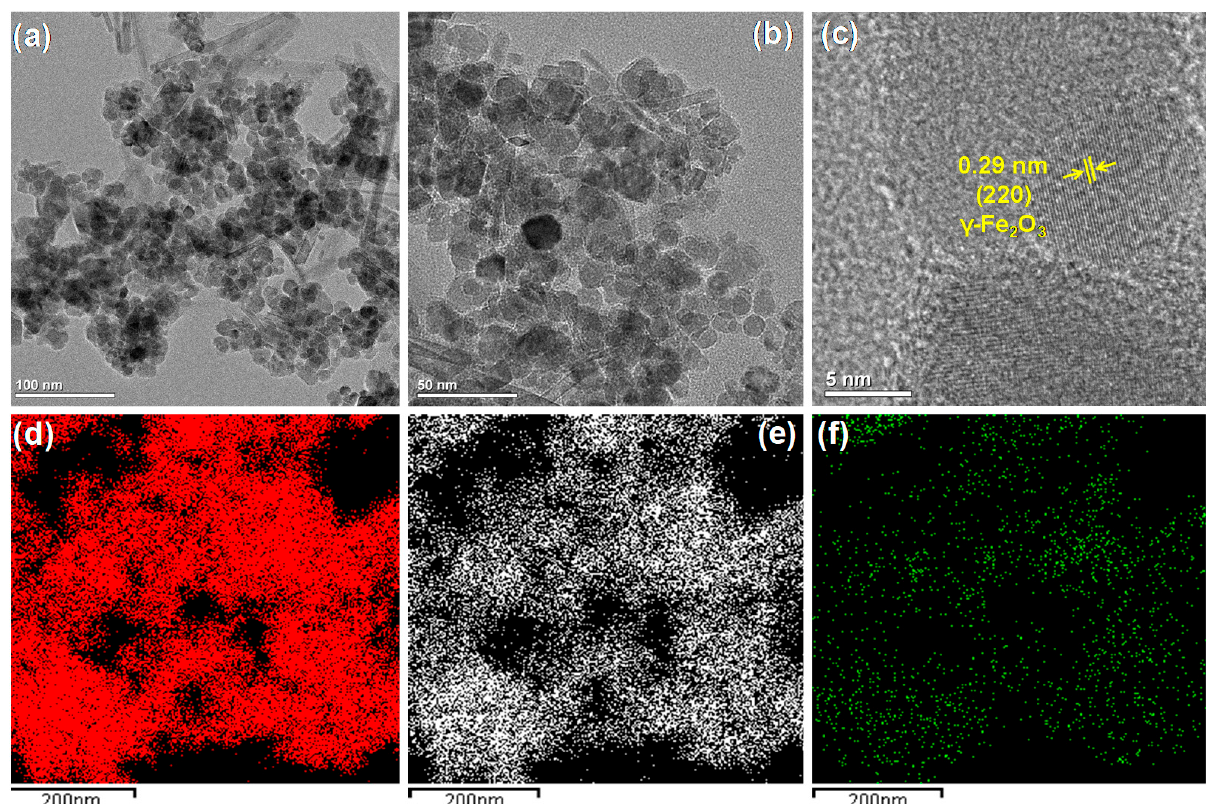
Figure 2. ( a , b ) Transmission electron microscopy (TEM) images and ( c ) high-resolution TEM image of the IB sample, with elemental mappings of ( d ) Fe, ( e ) O, and ( f ) P.